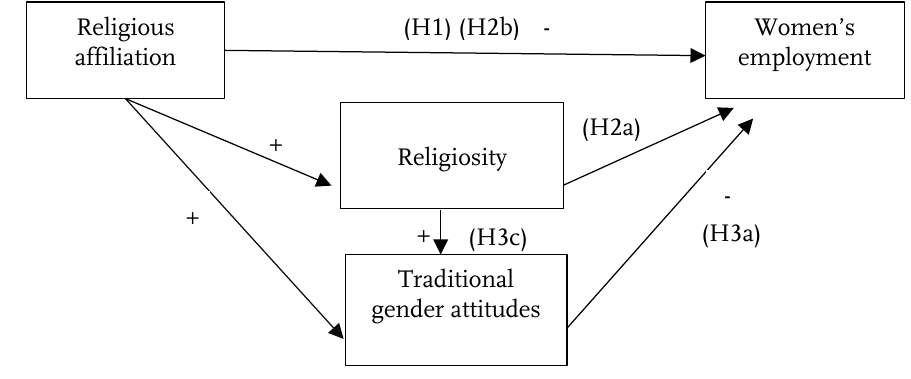
Figure 1 : Direct and mediating relationships between religion, religiosity, and gender attitudes in shaping women`s